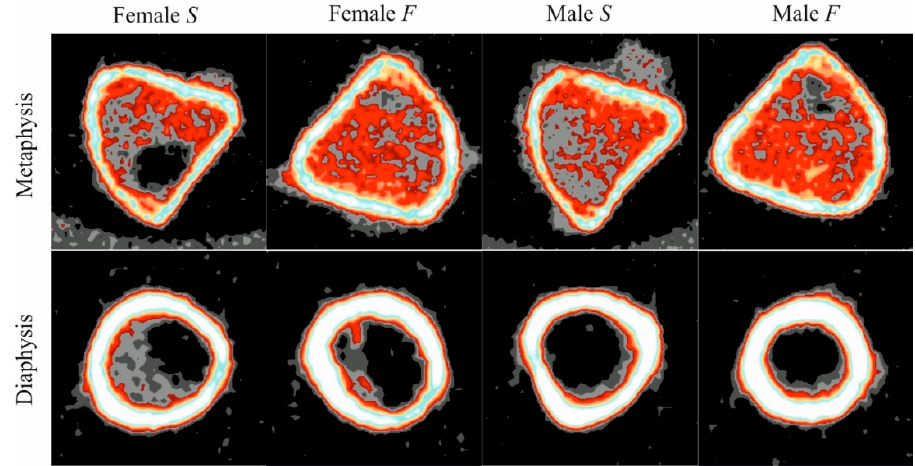
Figure 3. Representative peripheral quantitative computed tomography (pQCT) scan images of tibia performed in the proximal metaphysis and midshaft of the diaphysis of female and male rats on the weaning day.